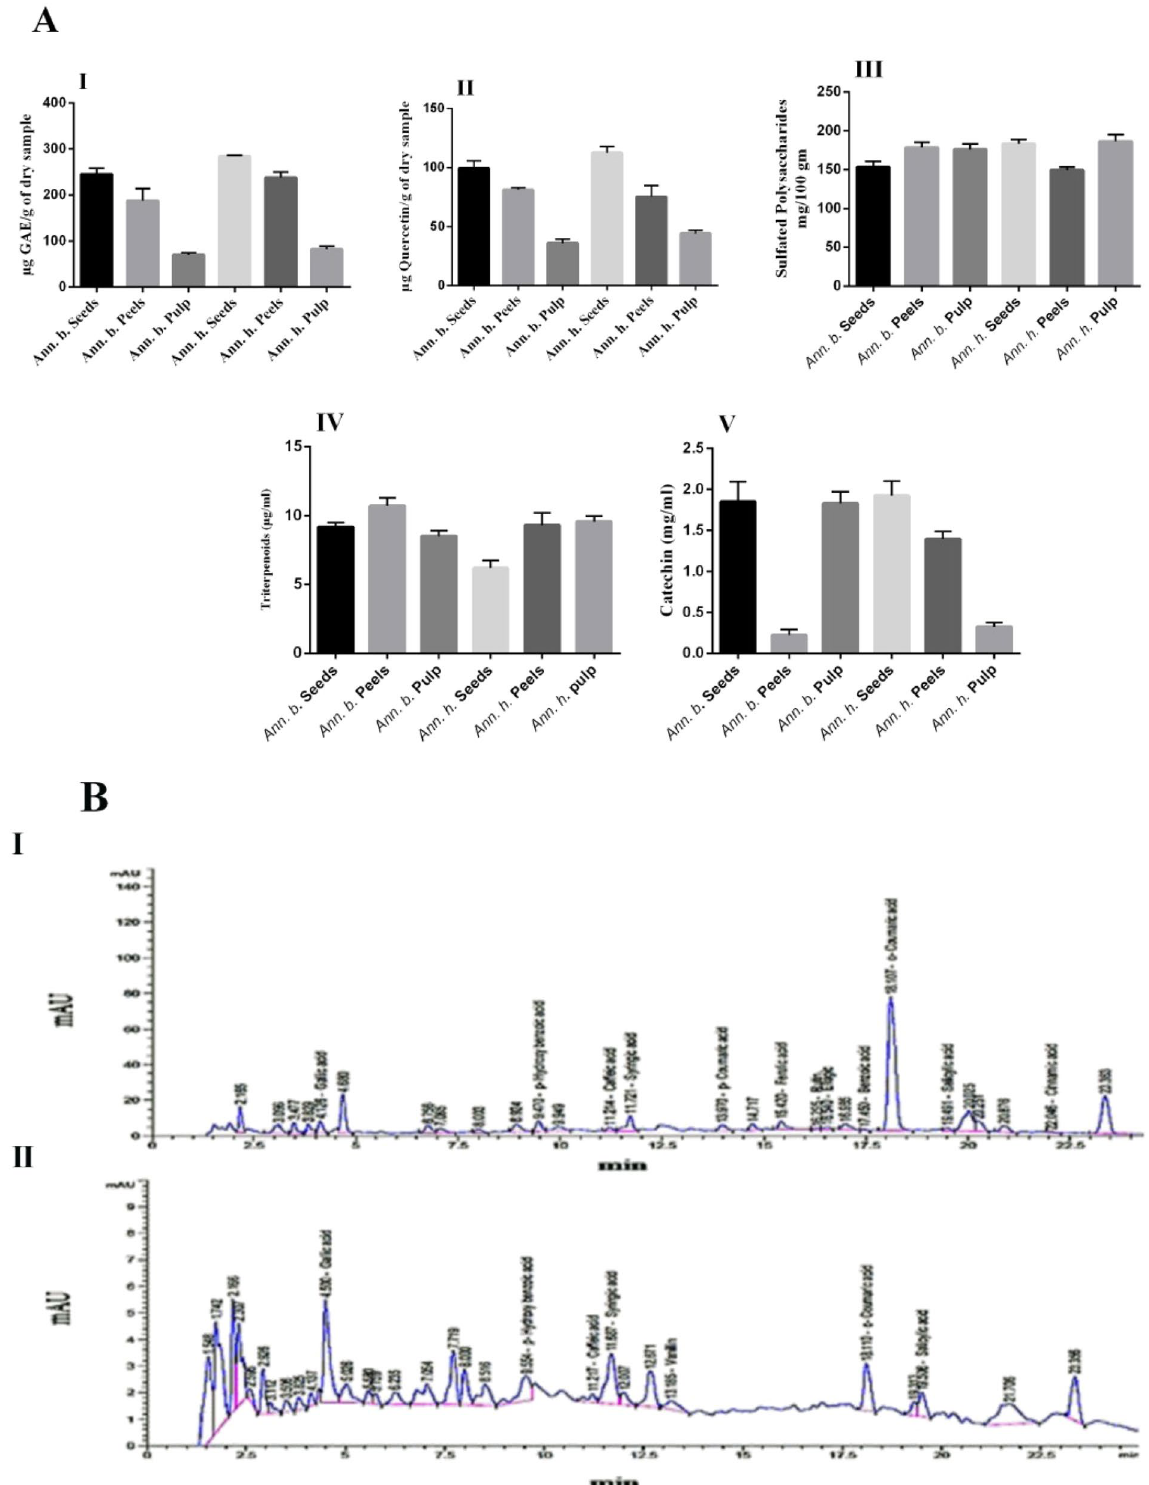
Figure 1. ( A ) Phytochemical content in pulp, seed, and peel of Annona (µg/g) (I) Total Phenolic, (II) Total Flavonoids, (III) Sulfated Polysaccharides, (IV) Triterpenoid, (V) Tannin. ( B ) Representative RP-HPLC chromatograms of phenolic compounds of seed extract of Annona sp.: (I) Annona b. (II) Annona h. Peak identifications were performed by matching retention time and UV spectra against standard